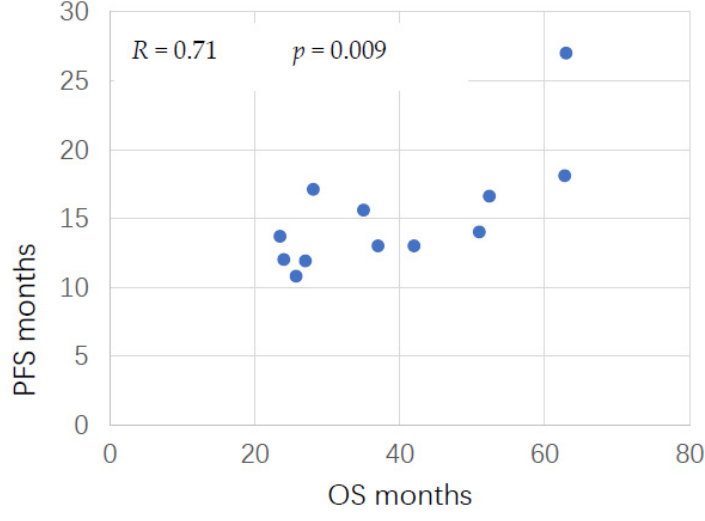
Figure 2. Overall survival (OS) and progression-free survival (PFS) Spearman’s rank correlation in series with no control group. Each dot corresponds to a series in which OS and PFS are available. R is the correlation coefficient. Table 4. Series of cytoreductive surgery and hyperthermic intraperitoneal chemotherapy (HIPEC) for ovarian cancer first relapse with a control group: residual tumors and survival results. (PICO: Outcomes OS and